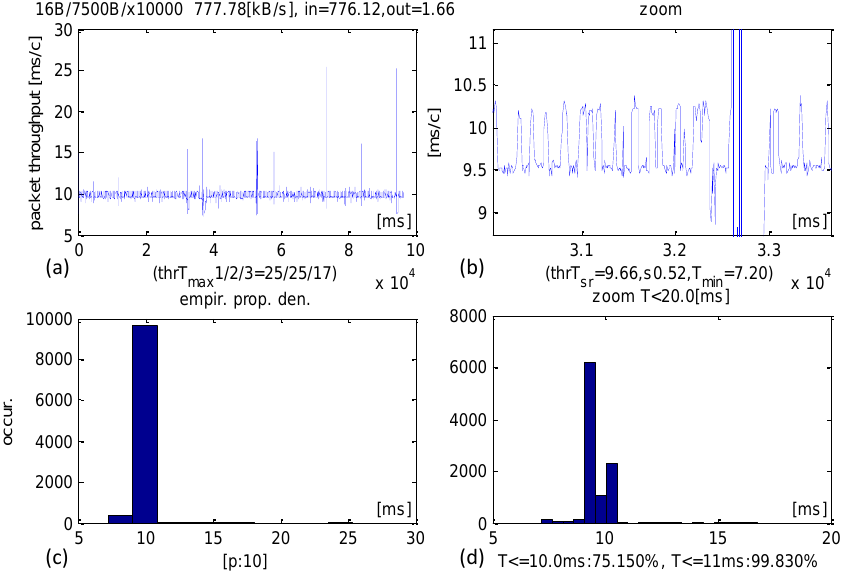
Figure 8. Experimental results of CCLT for packets IN = 7500 B. ( a ) Recorded CCLTs. ( b ) Enlargement of selected section. ( c ) CCLT histogram. ( d ) Selective histogram enlargement.